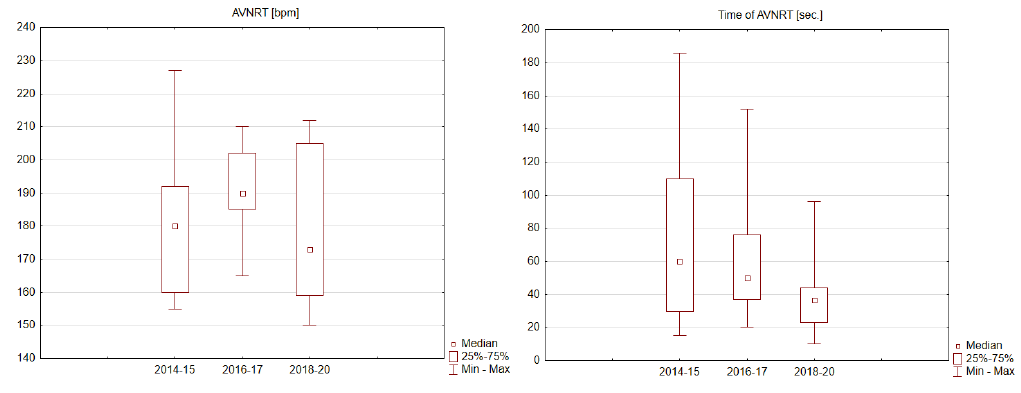
Figure 2. Intensity and time of atrioventricular nodal re-entrant tachycardia (AVNRT) in 2014–2020 of analyzed patient.